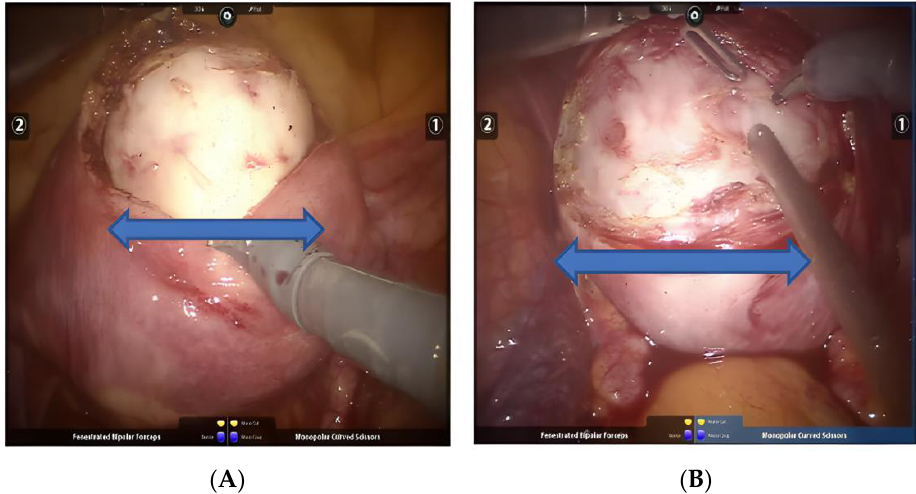
Figure 2. ( A , B ) Transverse incision in the anterior (posterior) wall of the uterus. Arrows point to the directions of incision.